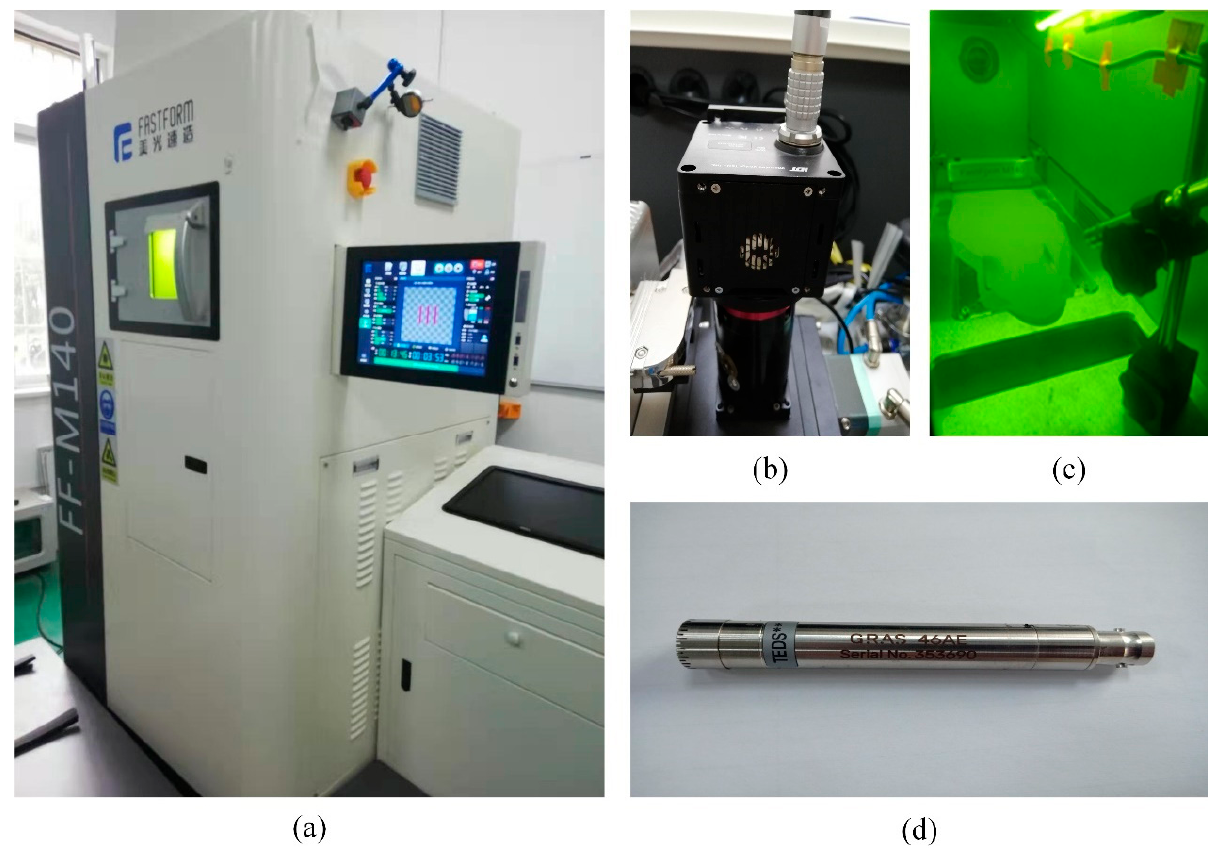
Figure 1. The setup and arrangement of the experiments: ( a ) The SLM equipment, ( b ) the high-speed camera, ( c ) the arrangement of the microphone in the build chamber, and ( d ) the microphone sensor.